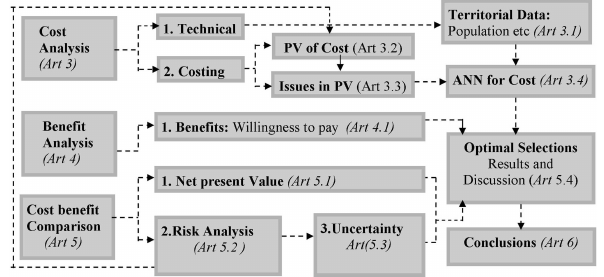
Figure 1. Flow diagram of the cost benefit